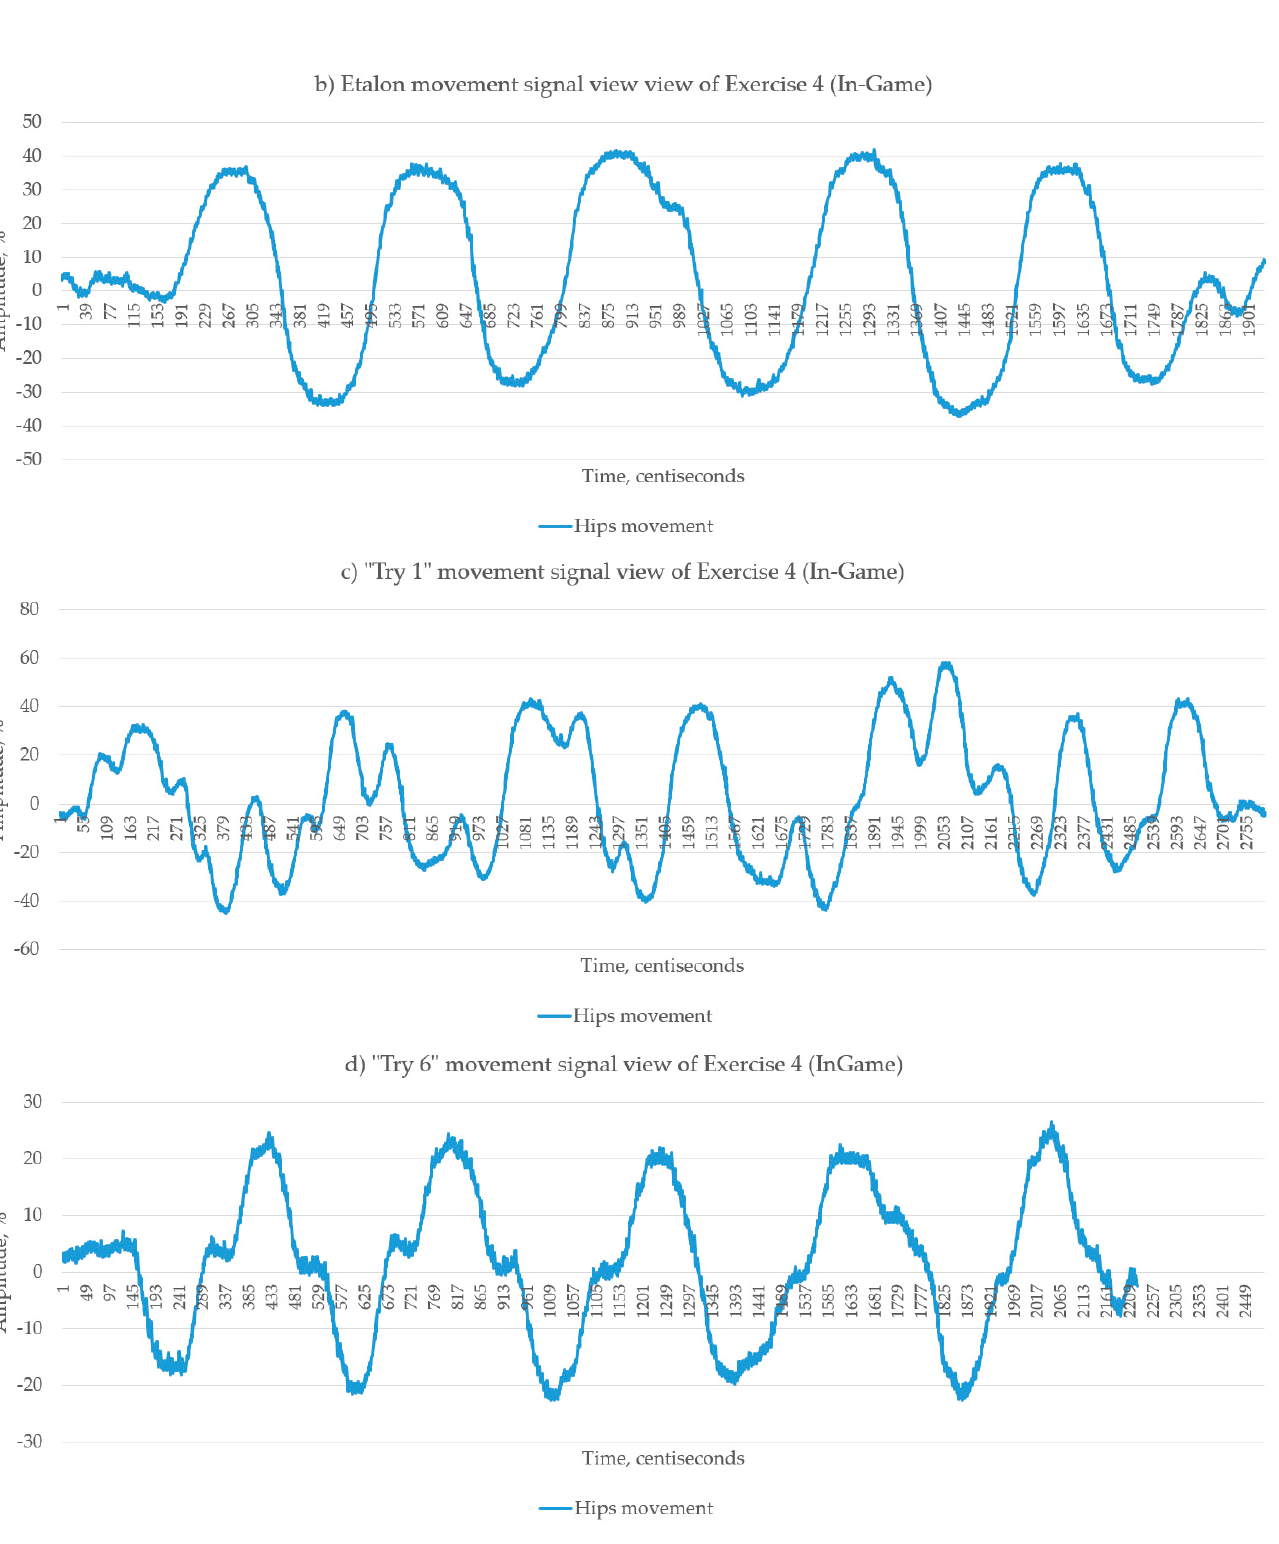
Figure 14. Example of the difference in the pattern of movements for different interpretations of Exercise 4. Where ( a )—etalon signal view for standard exercise interpretation, ( b )—etalon signal view for In-Game exercise interpretation, ( c )—example of In-Game signal view of Ty 1, ( d )—example of In-Game signal view of Try 6.